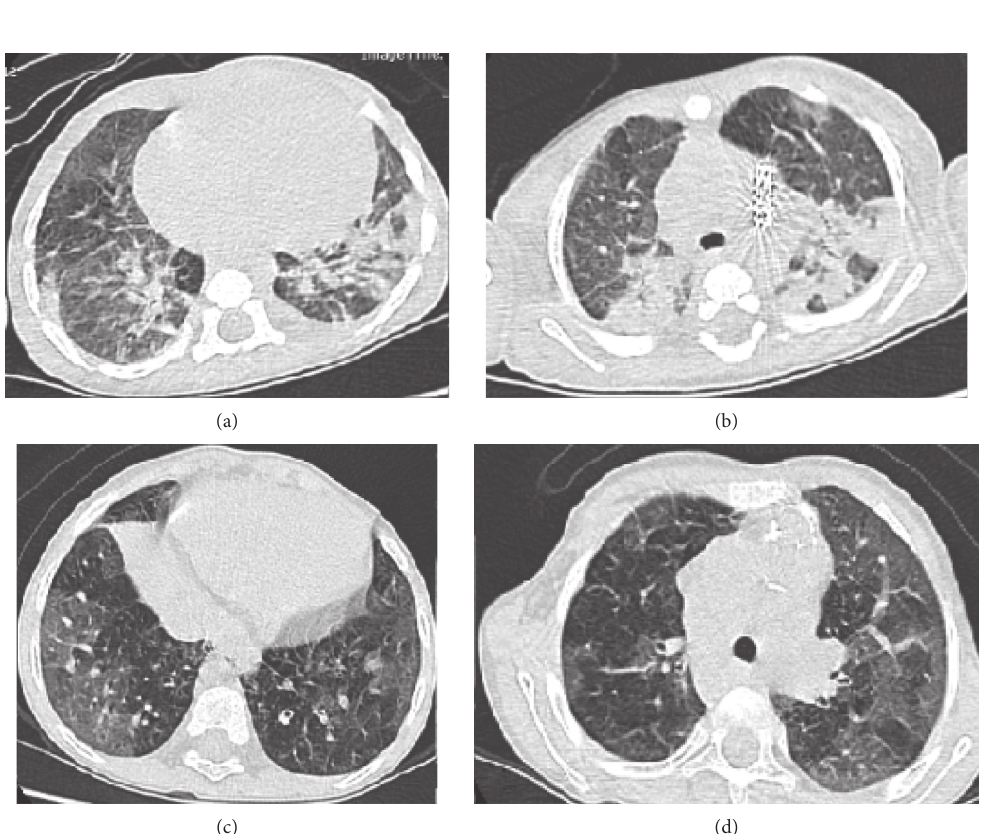
Figure 1: CT scan (a, b) of patient 1 with subpleural alveolar consolidations, deformed interlobular septal thickening, and mosaic at- tenuation. Ductal stent can be seen in (b). CT scan (c, d) of patient 2 with diffuse ground-glass